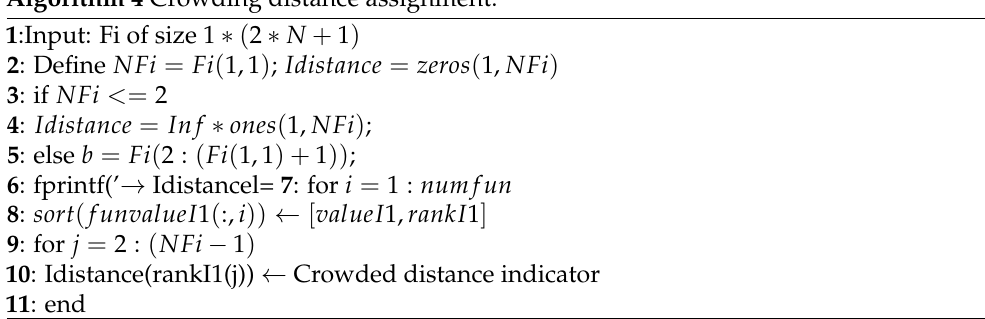
Algorithm 4 Crowding distance assignment.